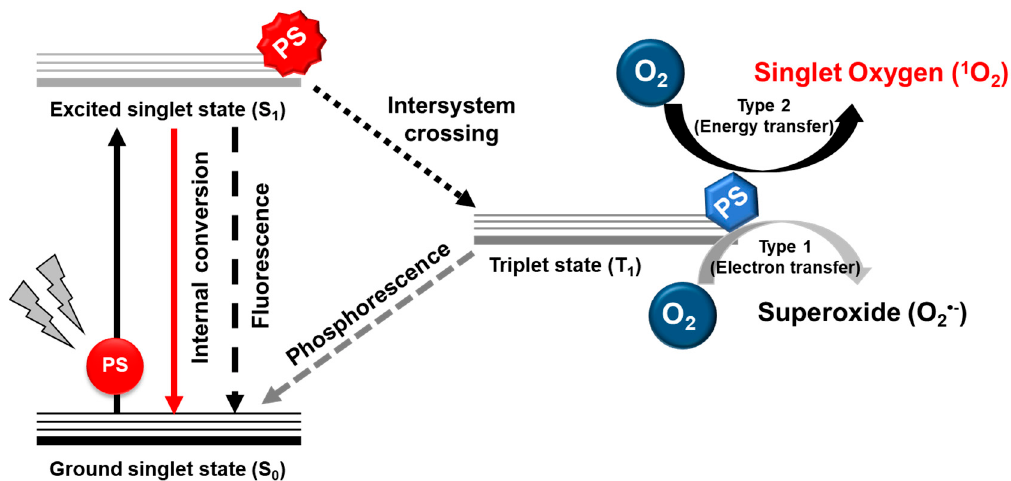
Figure 2. Schematic illustration of the mechanism behind the photodynamic process. The PS harvests energy from light with a suitable wavelength to excite an electron from the ground singlet state (S 0 ) to the excited singlet state (S 1 ) followed by intersystem crossing to the triplet state (T 1 ). In this state, PS interacts with oxygen molecule to generate ROS.